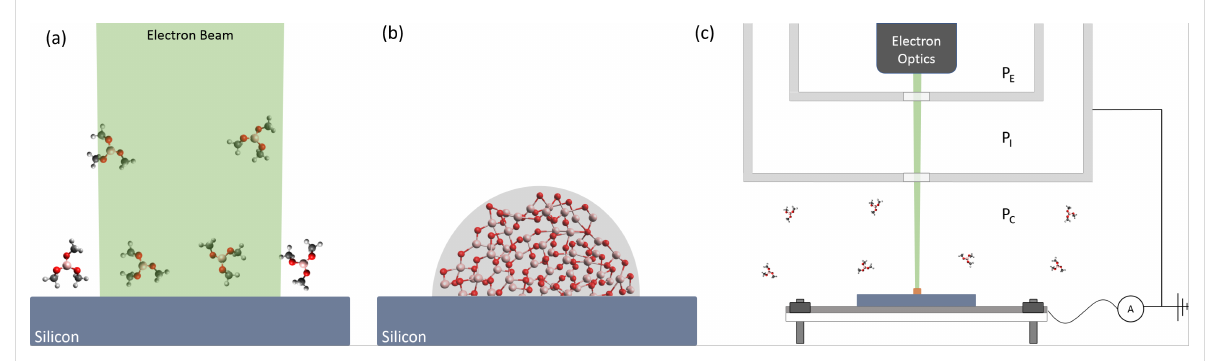
Figure 1: The EBID process and instrumentation. (a) Gaseous TMB precursor is admitted into the vacuum chamber where it adsorbs to the silicon substrate surface. (b) An electron beam dissociates adsorbed precursor molecules creating non-volatile fragments that bind to the surface forming a solid. (c) Schematic of the system using large-area EBID. The system comprises an electron flood gun, heater assembly, substrate current measure- ment circuitry, and three differentially pumped vacuum regions (P E , P I and P C ), which allows the electron optics to be maintained at high vacuum (ca. 10 − 3 Pa) while the pressure in the process chamber is of the order of 1